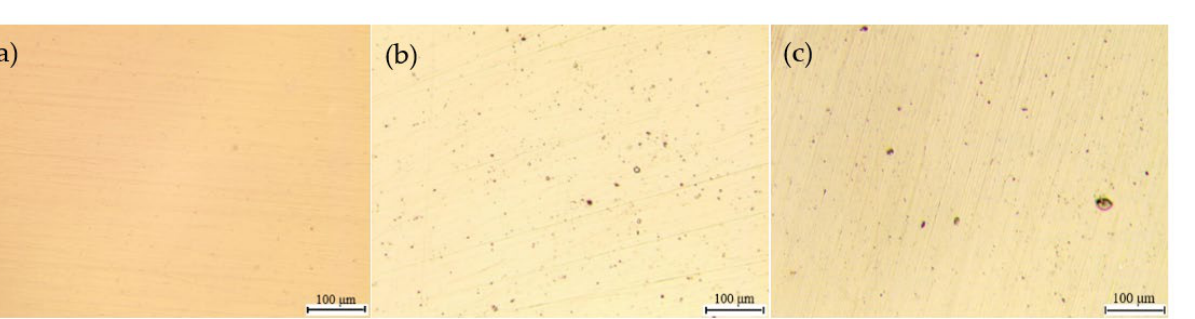
Figure 3. Optical micrographs (100 times) of 304 SS: ( a ) before polarization, ( b ) after polarization in 0.6 mol/L NaCl solution, ( c ) after polarization in 0.6 mol/L NaCl solution with 3.2 mol/L HAc.